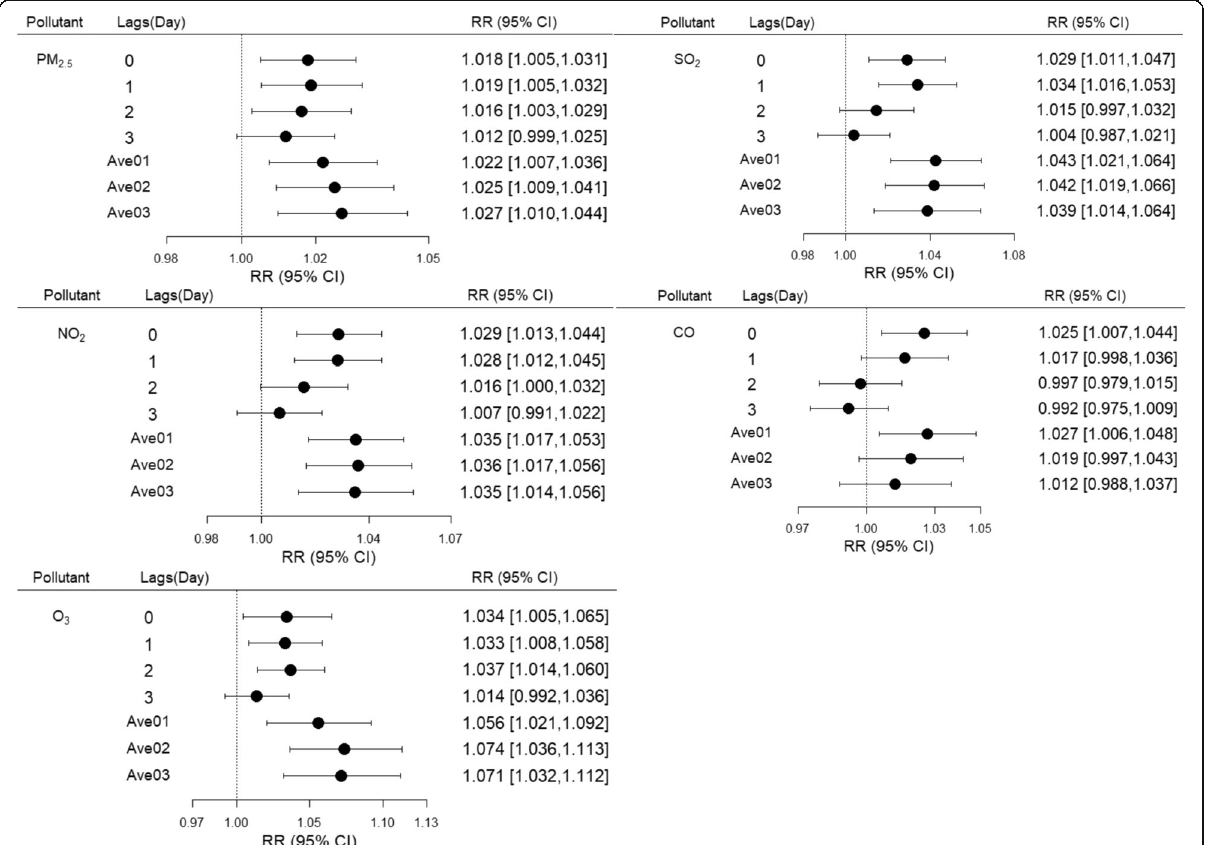
Fig. 2 Associations between IQR increases in PM 2.5 , SO 2 , NO 2 , CO, and O 3 and COPD-related mortality among elderly people at lag0, lag1, lag2, lag3, lag01, lag02, and lag03 days, respectively. All models were adjusted for daily temperature and relative